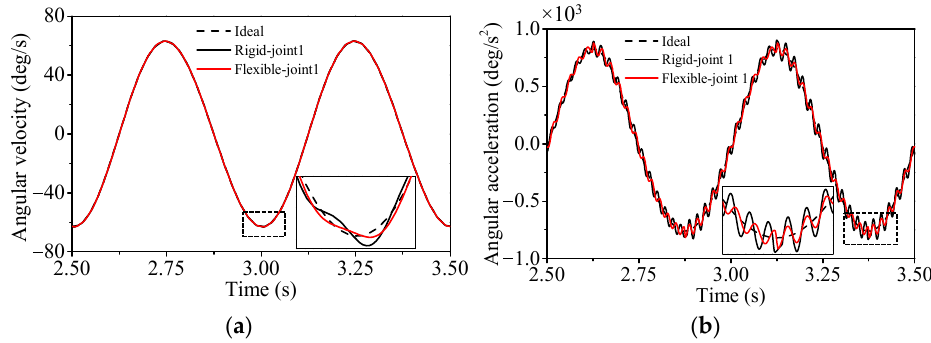
Figure 19. Effects of clearance at joint 1 when considering the flexibility of the auxiliary rod: ( a ) angular velocity; ( b ) angular acceleration.